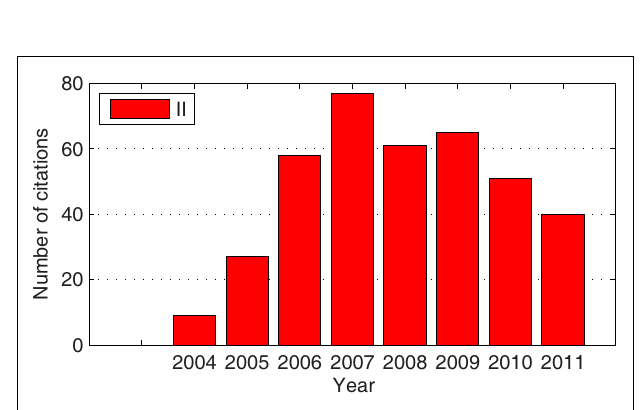
FIGURE 2 | Citations of the articles by the competition winners. The histogram shows how many times the articles of the winning teams of BCI competition II (describing the winning algorithms) have been cited in ISI-indexed journals. Data were retrieved from the ISIWeb of Knowledge on December 1st